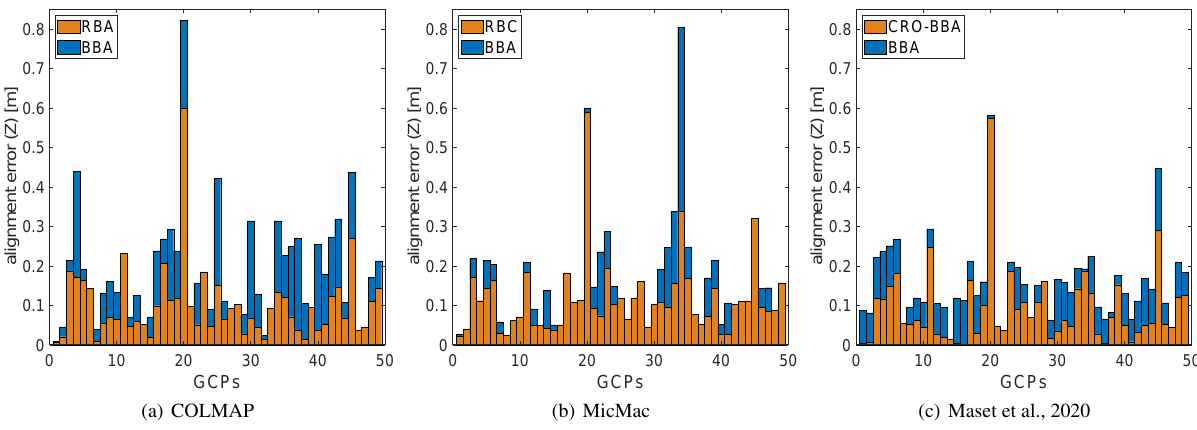
Figure 3. Results of the comparison experiments for the Leica CityMapper dataset between the unconstrained (blue bars) and constrained (orange bars) bundle adjustments. Planimetric component of object-space errors for GCPs.